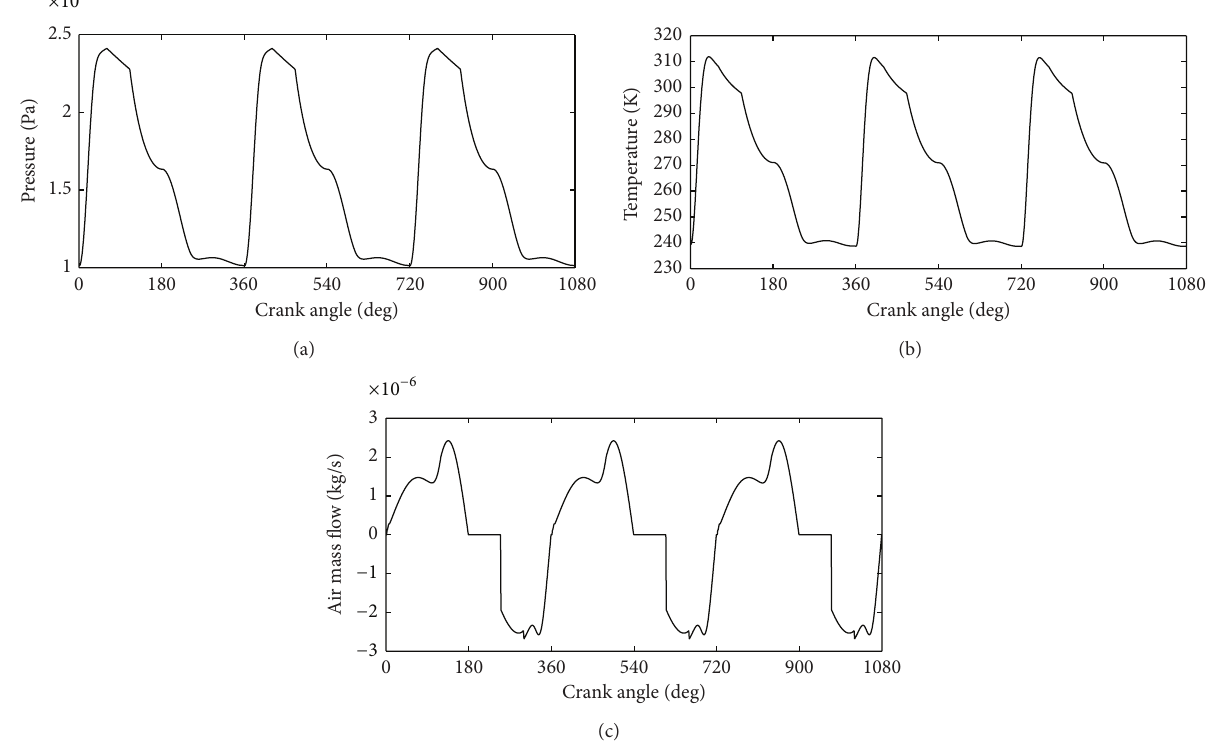
Figure 3: Pressure curve, temperature curve, and mass curve of the cylinder.